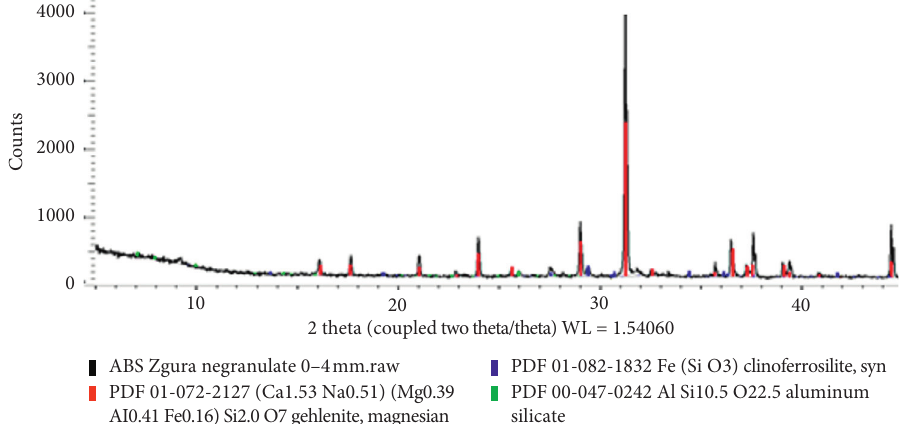
Figure 3: X-ray diffraction spectrum for ABS with characteristic lines for magnesian gehlenite, clinoferrosilite, and aluminium silicate.